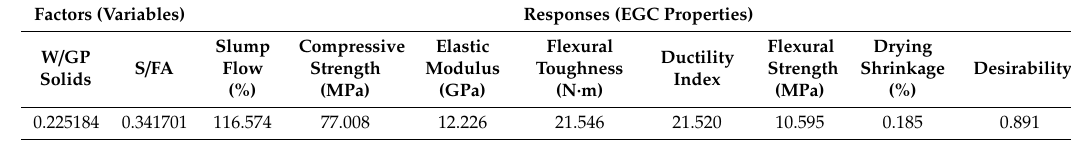
Table 11. Optimized solutions with desirability.